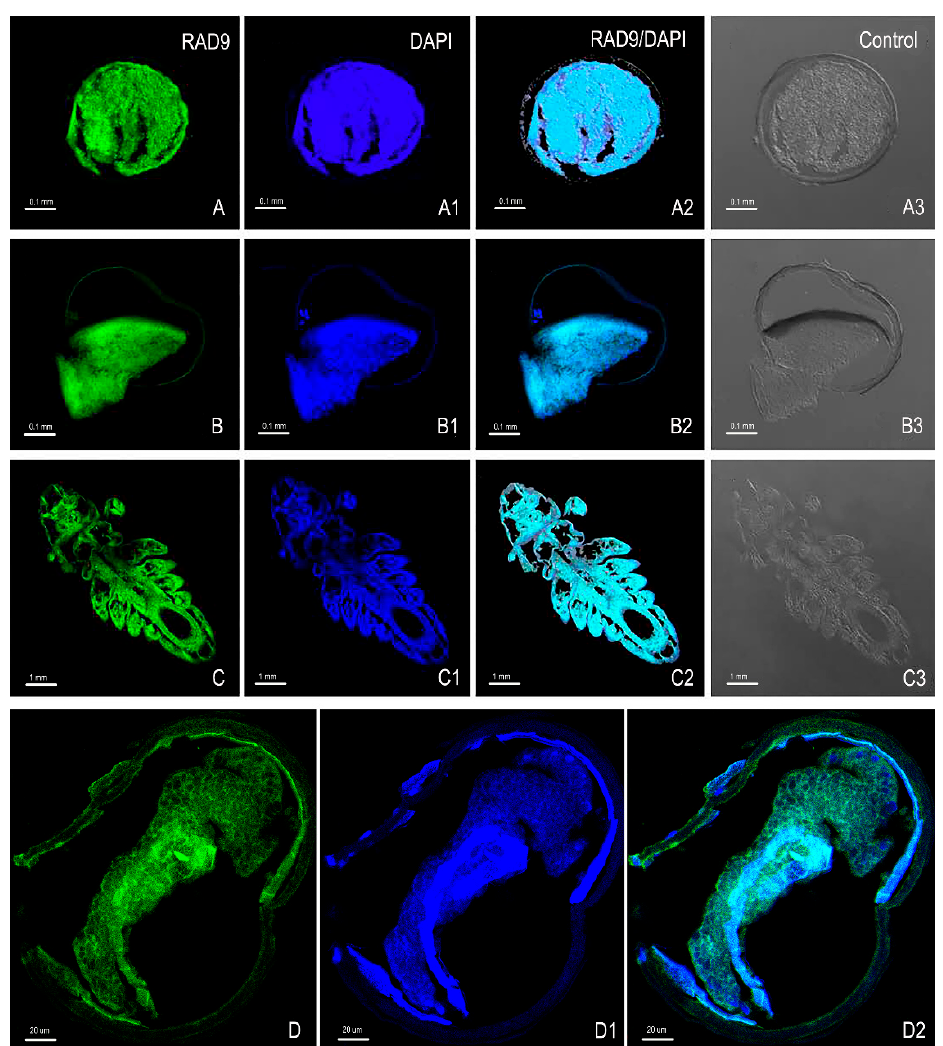
Figure 8. Immunofluorescence analyses of As– RAD9 at the embryo and adult stages of A. sinica. The paraffin sections of different development stages were prepared for immunofluorescence microscopy. A (0 h), B (15 h), C (7 days), and D (10 h) represent single-labelled with polyclonal anti-RAD9; A1 , B1 , C1 and D1 represent single-labelled DAPI (nuclear blue fluorescent probe); A2 , B2 , C2 , and D2 represent with the image overlay of control group samples dual-labelled with polyclonal anti-RAD9 and DAPI; A3 , B3 , and C3 represent the image overlay of the control group samples single-labelled with secondary antibody.